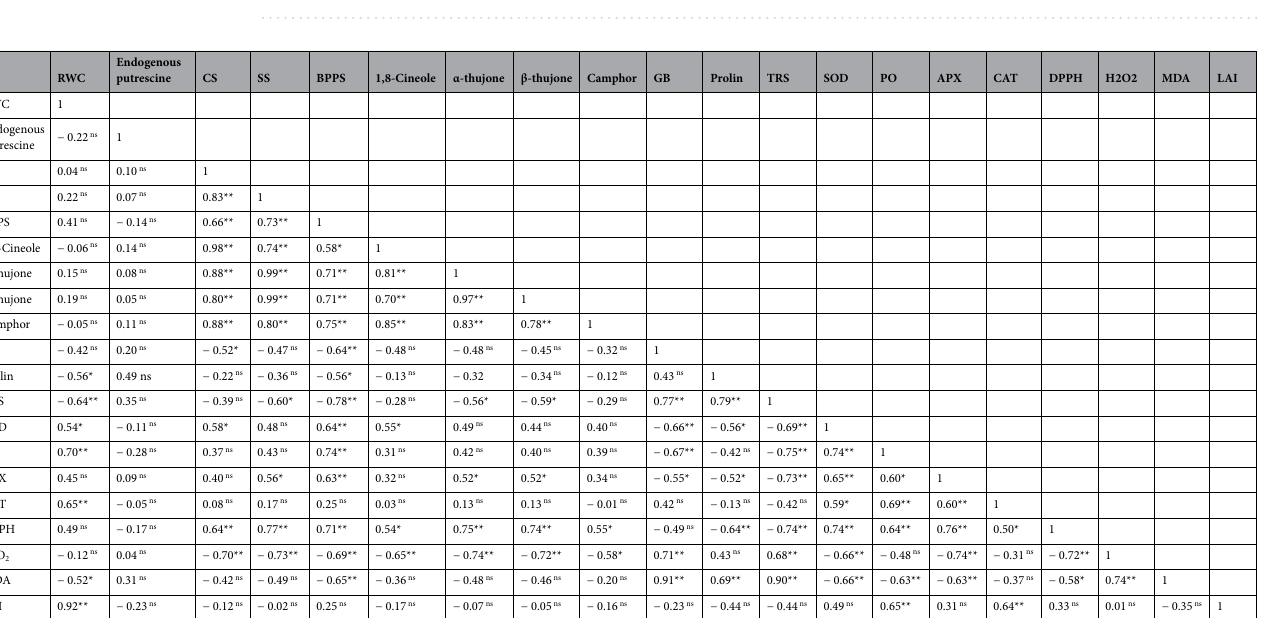
Figure 6. Interaction between irrigation regime and putrescine on H 2 O 2 ( A ) and MDA ( B ). The different letters show significantly different at the level of 0.01. The error bars represent standard error.